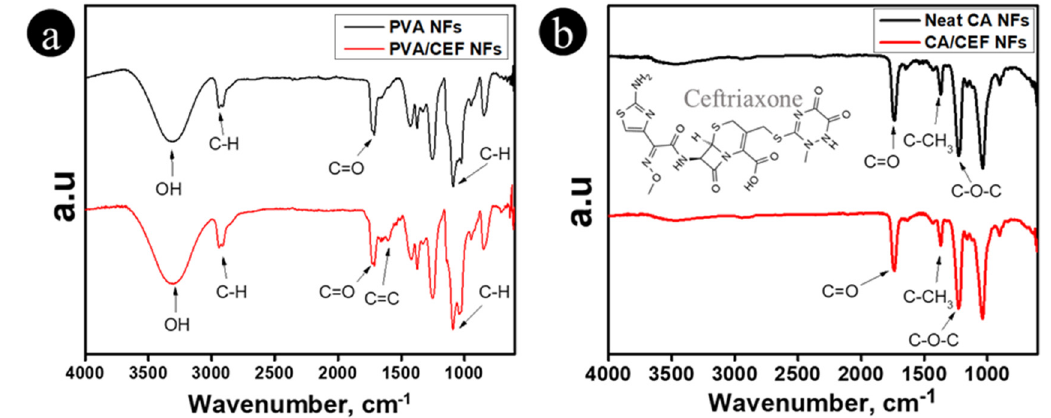
Figure 2. FTIR spectra of nanofibers: ( a ) PVA, PVA/CEF NFs, ( b ) CA, and CA/CEF NFs.